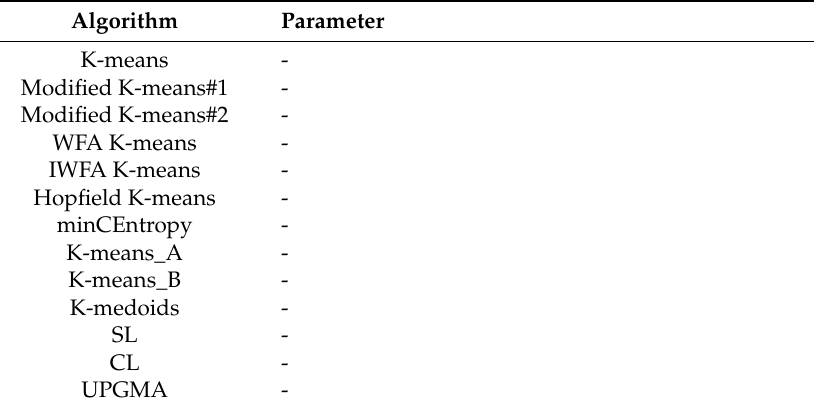
Table 7. Parameters updating